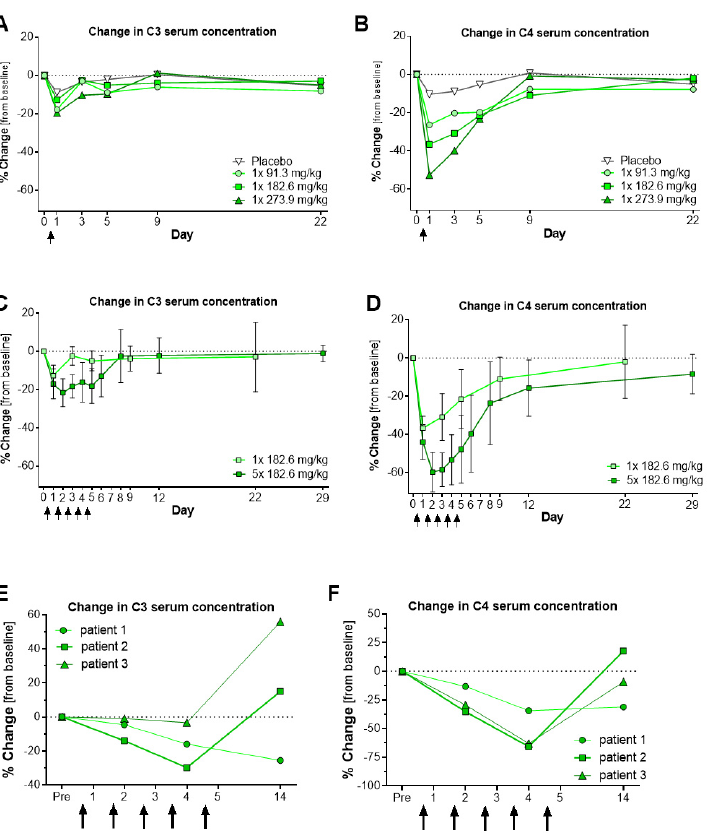
Figure 5. Pharmacodynamics of complement factor C3 and C4 upon trimodulin treatment in healthy subjects and sCAP patients. ( A – D ) Results from the phase I clinical trial with trimodulin (Study 970) showing the change in C3 and C4 serum concentrations before (Day 0), during and after single (1x 182.6 mg/kg BW, ( A , B ), n = 4) or multiple (5x 182.6 mg/kg BW, ( C , D ), n = 6) doses of trimodulin (arrows) in healthy subjects. Multiple doses were given on five consecutive days 1 through 5. ( E , F ) Results from the phase II clinical trial with trimodulin (Study 982, CIGMA). Multiple (5x 182.6 mg/kg BW) doses of trimodulin (arrows) were given to three patients with sCAP. Complement was assed at the end of infusion. Change was calculated as percentage change (% change) from baseline per subject and the mean was calculated per treatment group. (( A , B ): mean values, ( C , D ): mean values ± SD with n = 6; ( E , F ): single patient values). BW: body weight; SD: standard deviation; C3: complement factor 3.